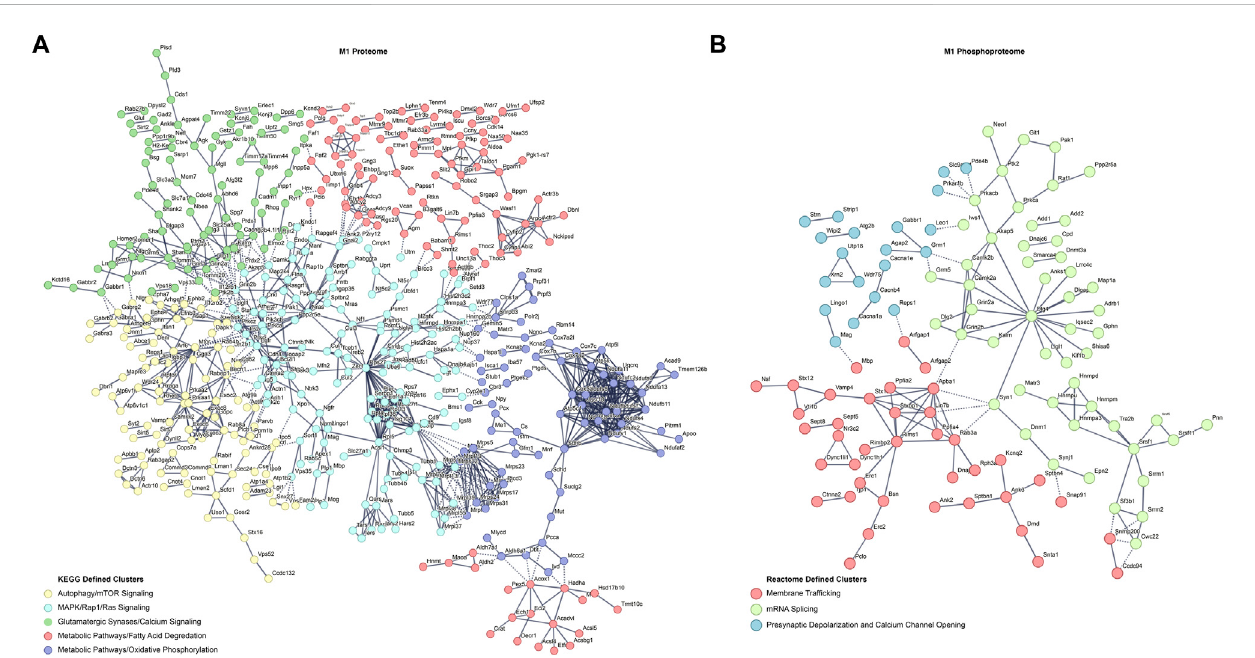
FIGURE 2 Differential protein and phosphopeptide interaction networks in the primary motor cortex (M1) of prenatal methadone exposed offspring. Interaction networks for the differential proteome (A) and phosphoproteome (B) . Interaction networks were k-means clustered and the strongest KEGG or Reactome termofthesubclusterwasusedtode fi netheindividualsubclusterSolidlinesrepresentinteractionsbetweenproteinsorphosphopeptidesinthesamecluster and dashed lines represent interactions between proteins or phosphopeptides across